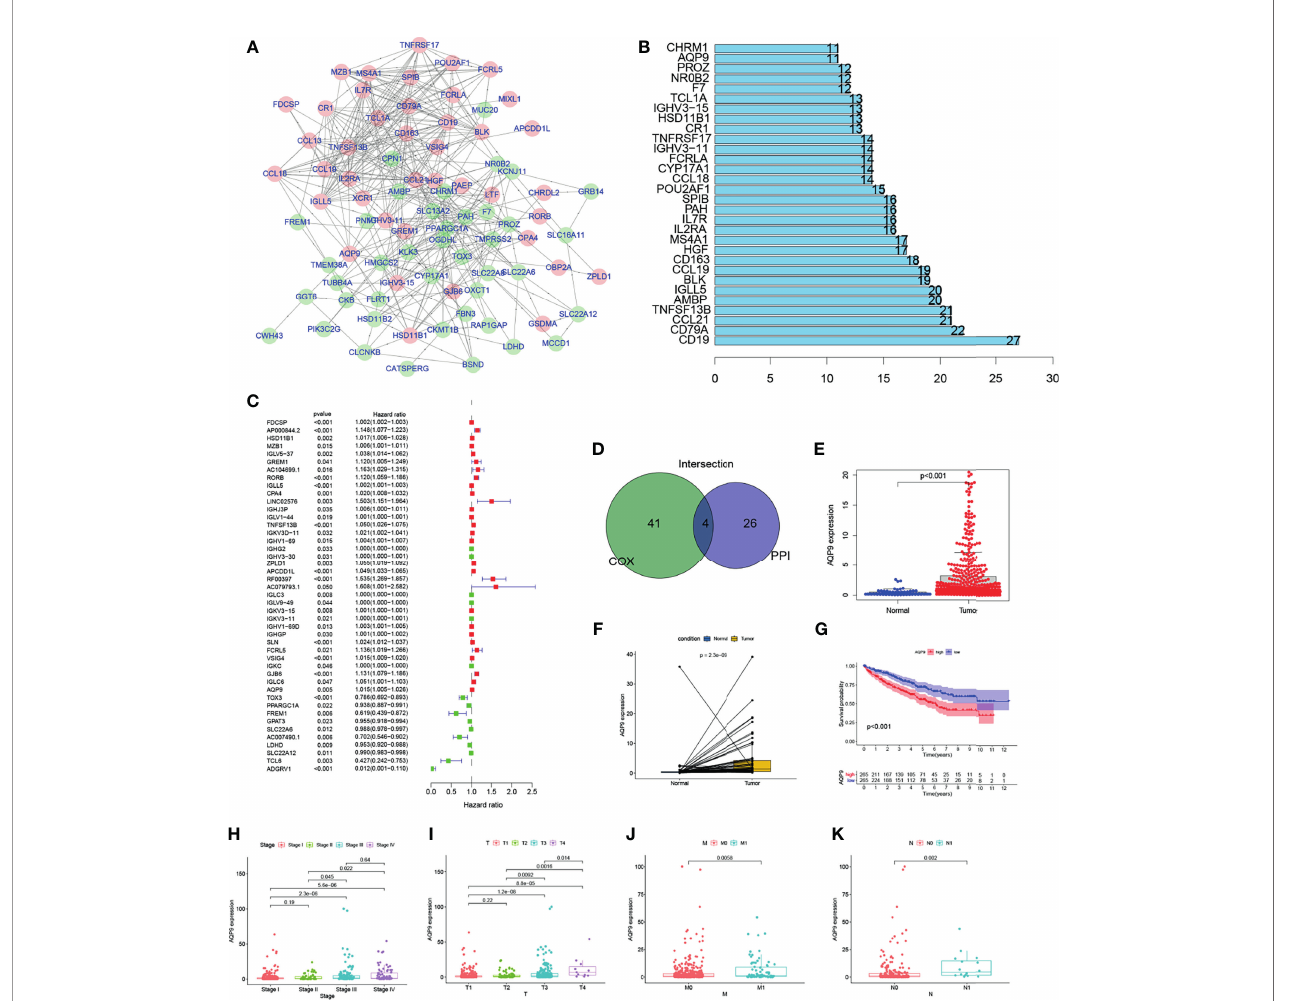
FIGURE 4 | The screening process and initial validation in clinical information of aquaporin 9 (AQP9). Genes with the top 20 Interaction node number (B) according to protein – protein interaction (PPI) network (A) were screened out. (D) Overlap between the uni-Cox regression (C) and PPI network. Expression bar chart (E) , paired expression bar chart (F) , and survival analysis (G) of AQP9. (H – K) The expression level of AQP9 in kidney renal clear cell carcinoma (KIRC) patients with different clinical and TNM